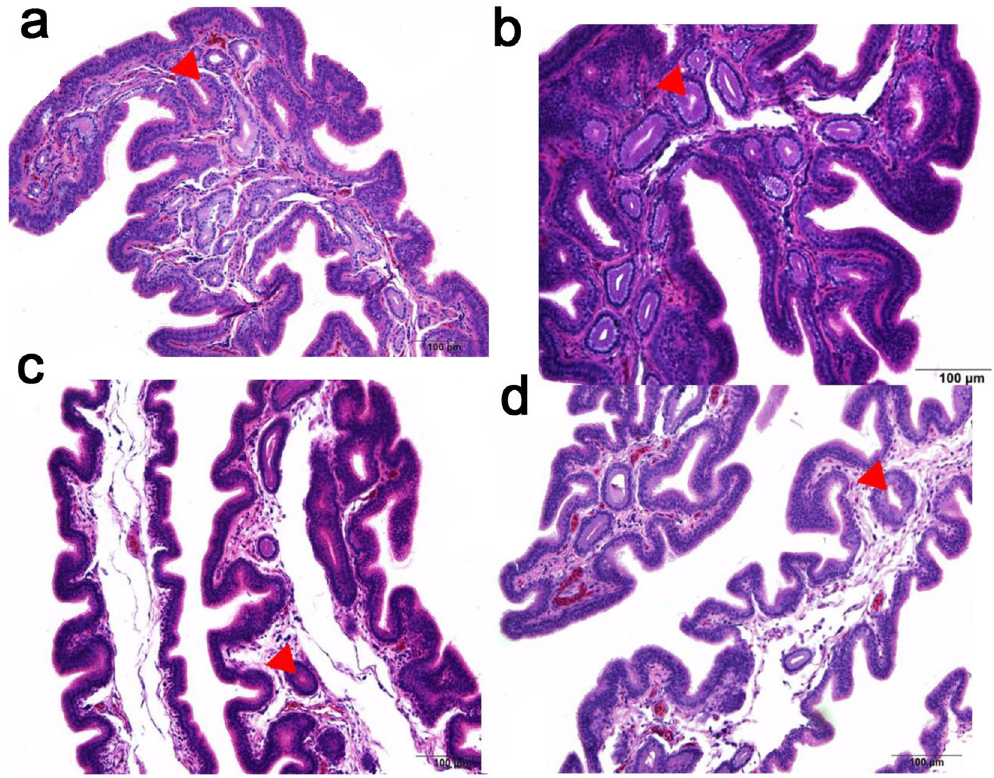
Figure 2. The panel of a tissue section of the UVJ of egg-laying hen. ( a , b ) long-DF hens and ( c , d ) short-DF hens. A rounded-like shape known as sperm storage tubule (SST) was more embedded in the UVJs of long-DF hens compared with short-DF hens. Data are presented as mean ± SEM (n = 4). P < 0.01 (Student’s t-test). The red arrow indicates the SSTs, Scale bar = 100 μ